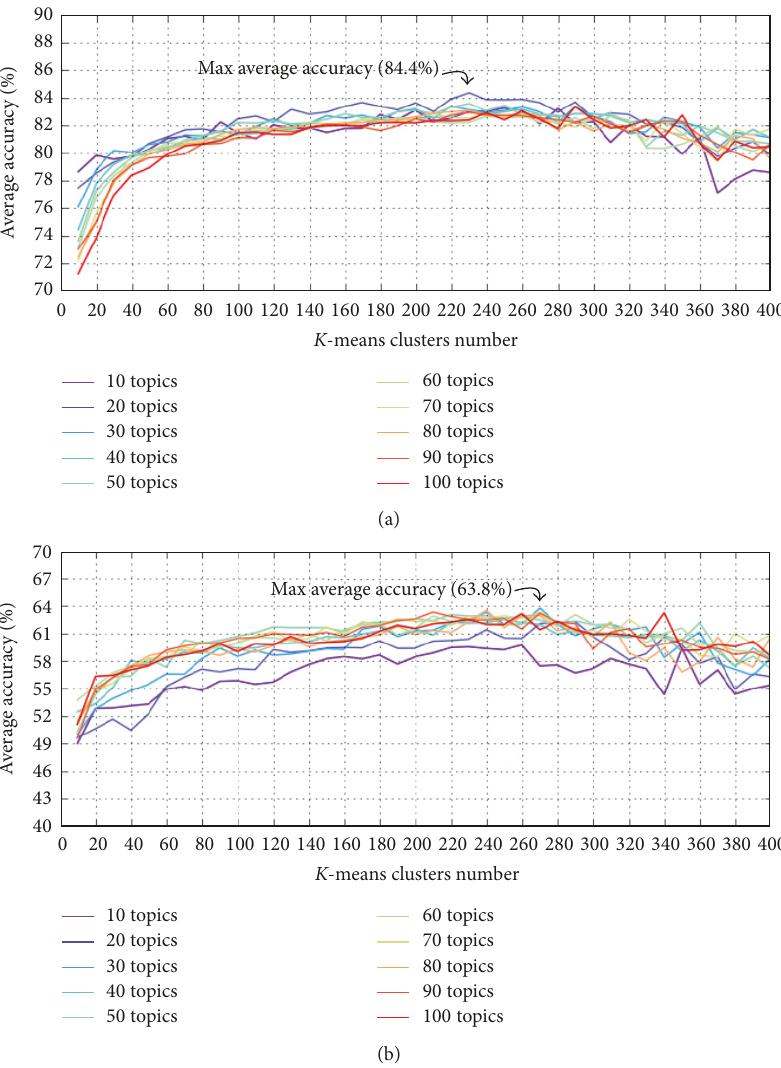
Figure 11: Average accuracy of (a) FrameDiff GridBlock Kmeans and (b) MultiCue GridBlock Kmeans , with 𝐾 ranging from 10 to 100 and 𝑐 ranging from 10 to 400.